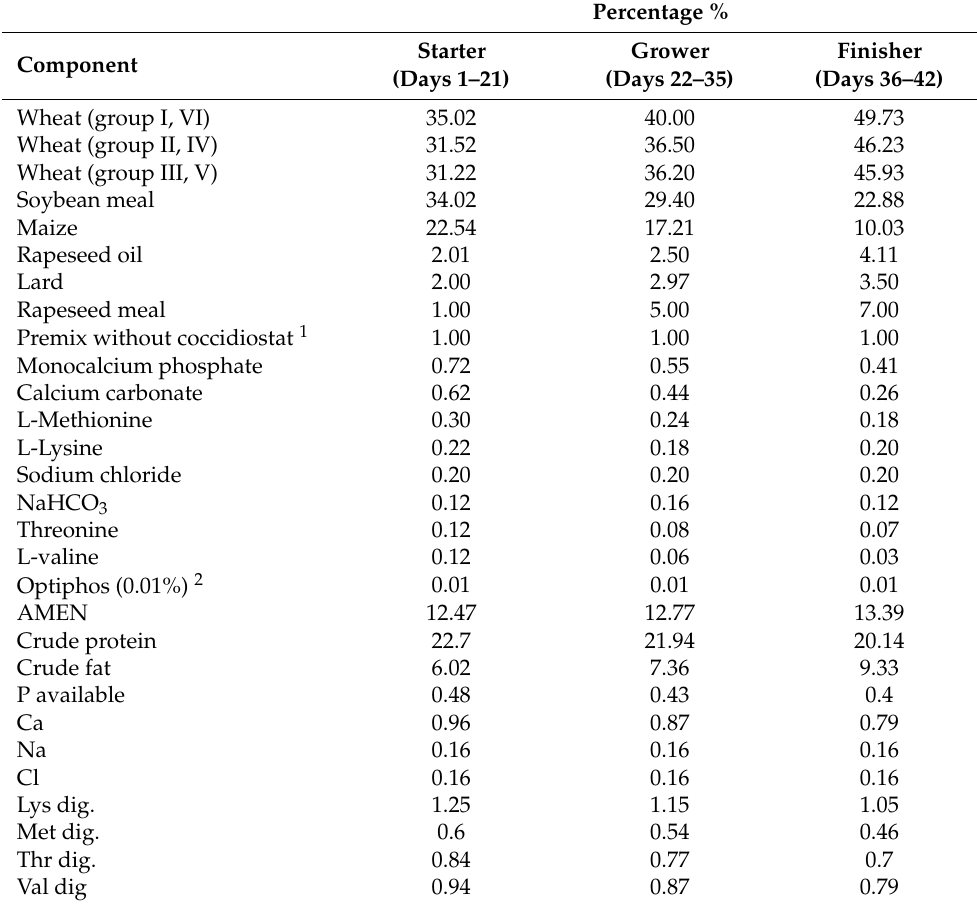
Table 2. Composition and nutrient value of basal diet